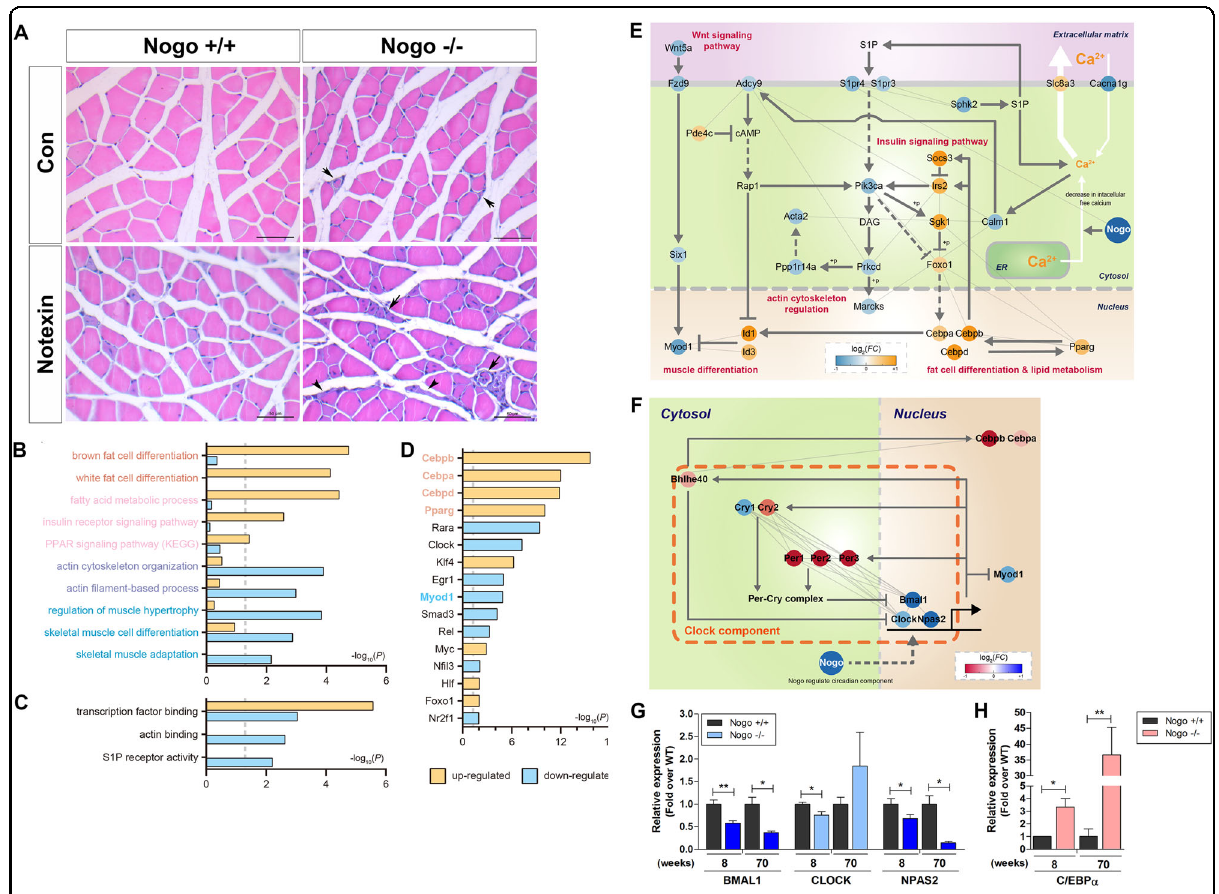
Fig. 3 Cellular processes affected by Nogo de fi ciency, and muscle physiology of notexin-induced Nogo − / − mice. A Representative images of hematoxylin/eosin stained non-injured control (Con, n = 5) and notexin-injured (500ng/gastrocnemius, n = 5) muscles from Nogo + / + or Nogo − / − mice. Short and long arrows indicate defective and regenerating myo fi bers, respectively. Arrowheads mark fi brotic cells. Scale bar = 50 µm. Gene Ontology biological processes (GOBPs) ( B ) and gene Ontology molecular functions (GOMFs) ( C ) represented by genes up- and downregulated by Nogo knockout. Enrichment signi fi cance was determined via p -values calculated with DAVID is displayed as − log 10 ( P ). P -values for up- and downregulated GOBPs or GOMFs are denoted using orange or light blue bars, respectively. p < 0.05. D Major transcription factors (TFs) that regulate a high number of differentially regulated genes (DEGs). Four upregulated TFs and one downregulated TF in Nogo − / − mice are labeled in orange and light blue, respectively. E Model network describing potential roles of Nogo in the regulation of myogenesis. Node colors represent upregulation (orange) and downregulation (blue) of the corresponding genes by the Nogo knockout. Arrows and suppression symbols denote activation and inhibition, respectively, based on the KEGG pathway database. Solid and dotted lines represent direct and indirect reactions, respectively, and gray lines represent protein – protein interactions between the connected nodes. The color bar represents gradient of log2 fold changes, log2(FC), between the Nogo − / − and WT muscle tissues. F Network model for circadian rhythm regulation in Nogo − / − mouse. Node colors represent upregulation (red) and downregulation (blue) of the corresponding genes by Nogo knockout. Arrows and suppression symbols denote activation and inhibition, respectively, based on the KEGG pathway database. Solid and dotted lines represent direct and indirect reactions, respectively, and gray lines represent protein – protein interactions between the connected nodes. The color bar represents gradient of log2(FC) between the Nogo − / − and WT muscle tissues. G , H qRT-PCR analysis for indicated genes in muscle samples from 8- and 70-week-old Nogo + / + ( n = 4) and Nogo − / − ( n = 3) mice. Mean ± SEM. * p < 0.05, ** p <